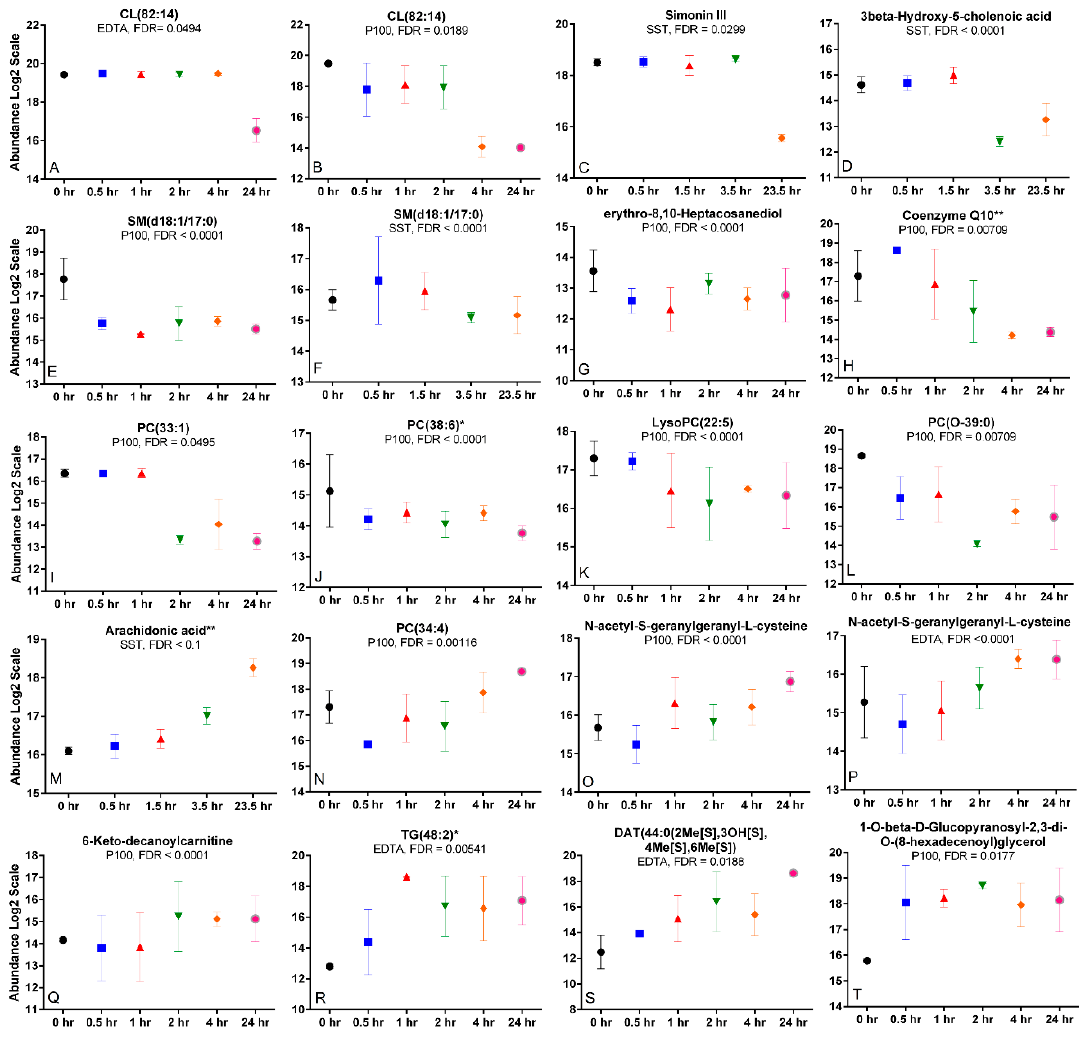
Figure 3. Metabolites affected by time. ( A – L ) Compounds whose abundance decreased and ( M – T ) compounds whose abundance increased with time in the indicated blood collection tube. Processing time differences are based on Repeated Measures ANOVA with FDR ≤ 0.1. * indicates identified by MSMS fragments to the NIST spectral library. ** indicates identified using standards and MSMS fragmentation. Error bars represent standard error of the mean, n = 3 subjects per time point.